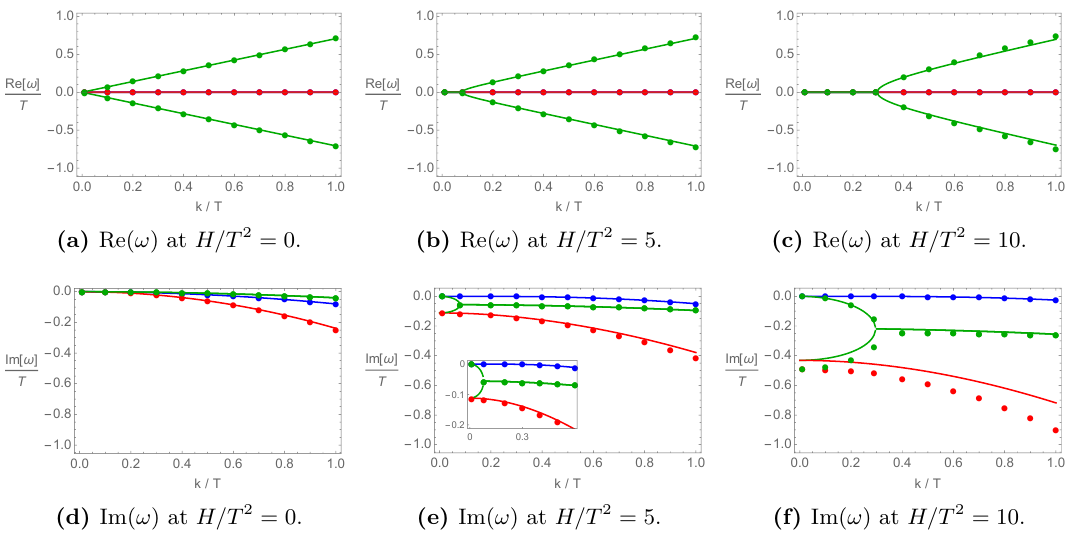
Figure 1. Quasi-normal modes vs dispersion relations from hydrodynamics at zero density ( µ/T = 0 ). Left: (a) and (d) at H/T 2 = 0 . Center: (b) and (e) at H/T 2 = 5 . Right: (c) and (f) at H/T 2 = 10 . All figures: colored dots are numerically computed quasi-normal modes and solid lines are dispersion relations from hydrodynamics by (2.11). For (a) and (d): the green data corresponds to the sound mode (2.16), the red data is the charge diffusion mode (2.18), and the blue data is the shear diffusion mode (2.18). For (b) and (e) (or (c) and (f)): the green data consists two dispersions (2.17): the energy diffusion mode, the cyclotron mode. The red data is another cyclotron mode (2.19) and the blue data is the subdiffusive mode (2.19).